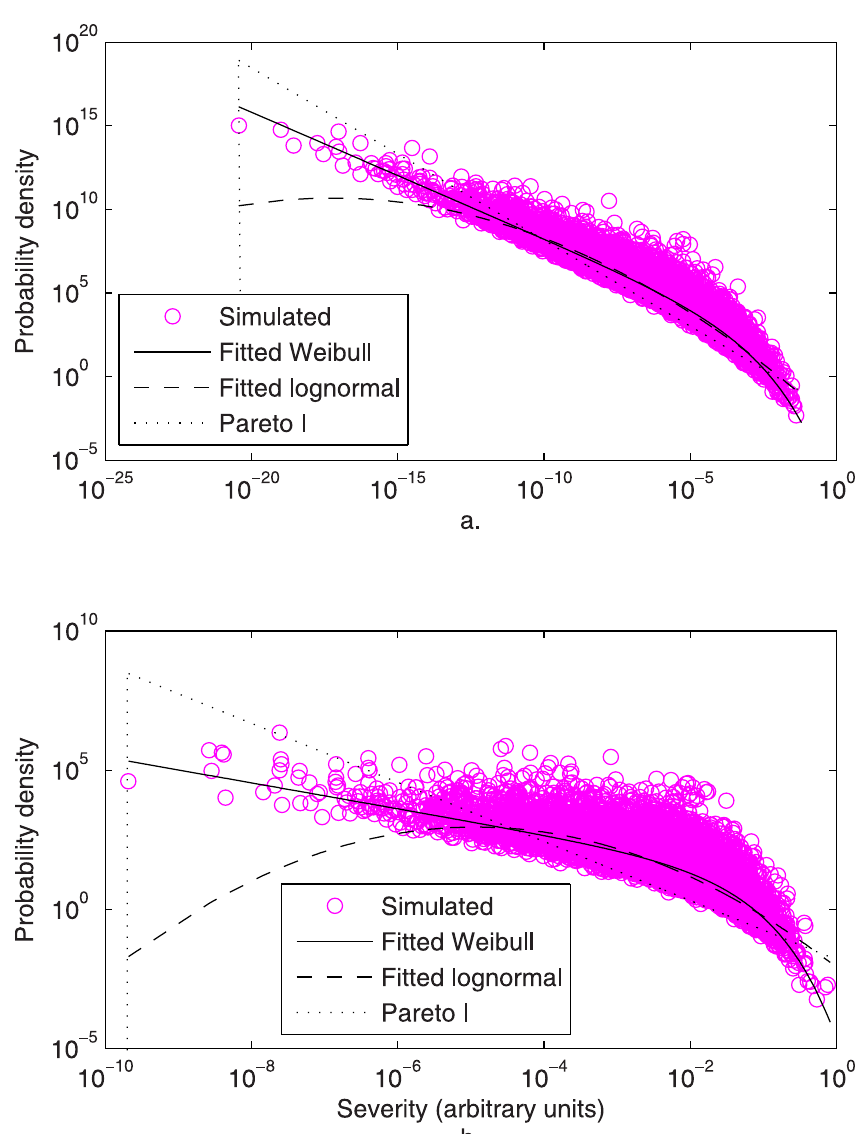
Fig 4. Simulated (o) and fitted Weibull ( –– ) and lognormal ( — ) distributions of illness severity. Severities were simulated as (a) the results of the multiplicative model of illness severities of Eq 12, and (b) the results of the simplified multiplicative model of illness severities of Eq 13. [Conditions: all fractions, f X , distributed standard exponential, N = 100,000; subsequent fractions correlated by copula; MLE parameter